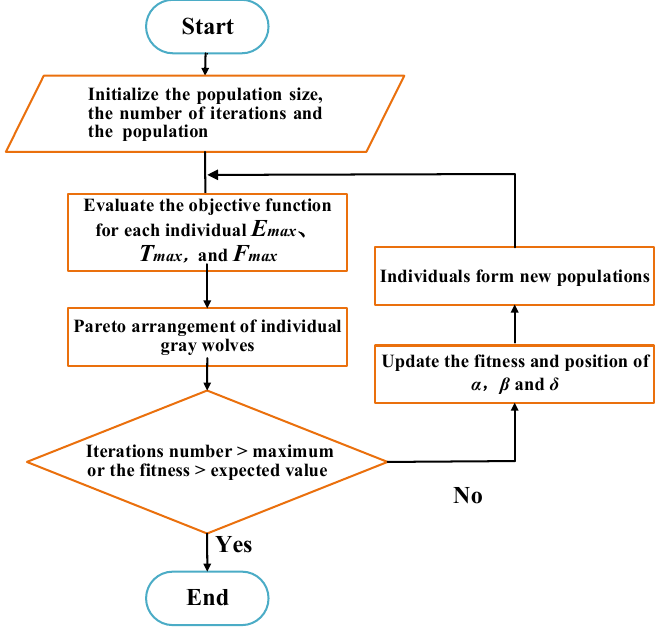
Figure 10. Flowchart of MOGWO algorithm.